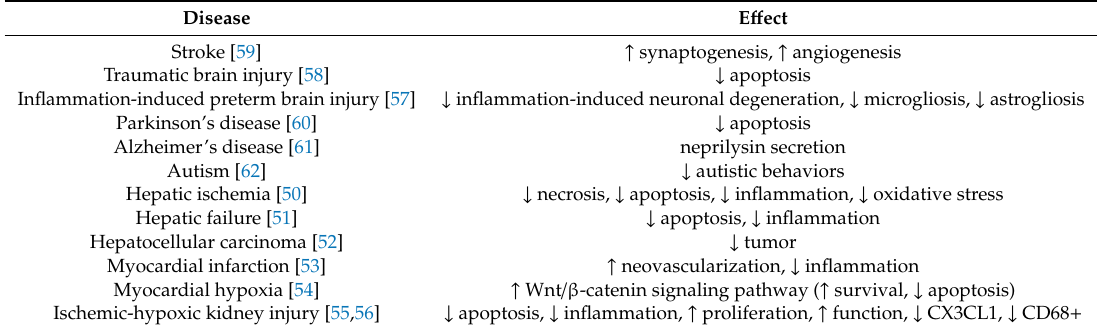
Table 2. E ff ects of extracellular vesicle administration in specific